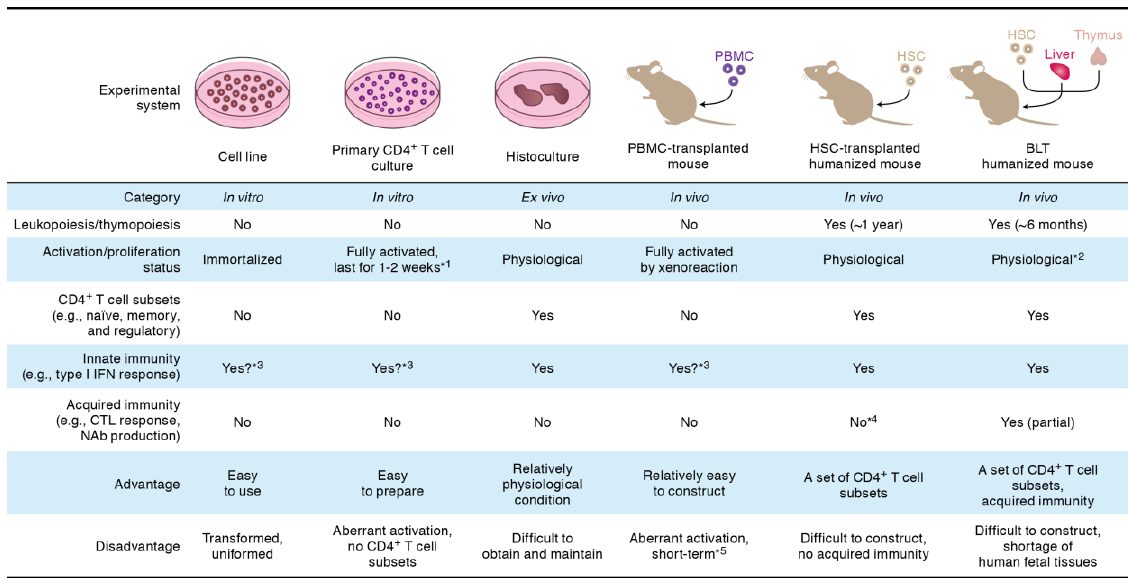
Figure 2. Experimental system for HIV-1 infection. The detailed explanation of each experimental system is described in the text. * 1 , to perform HIV-1 replication assays, primary CD4 + T cells should be artificially activated by mitogens (e.g., phytohemaggluttinin and anti-CD3/CD28 antibodies); * 2 , because human thymocytes are efficiently educated in human thymic transplant ( i.e. , human MHC), the human T cells differentiated in BLT humanized mice may recognize the tissues of recipient mouse as foreign antigen, which can lead to the onset of graft-versus-host reaction; * 3 , these systems are capable of responding type I interferon stimulation, which can lead to the expression of interferon-stimulating genes. However, these systems are incapable of triggering innate immune sensing because of the absence of dendritic cells and macrophages; * 4 , because human thymocytes are educated in the thymus of recipient mouse ( i.e. , murine MHC), the human T cells differentiated in HSC-transplanted humanized mice are unable to efficiently receive the antigen stimulation from human antigen presenting cells; * 5 , the transplanted human PBMCs recognize the tissues of recipient mouse as foreign antigen and cause graft-versus-host reaction, which results in the aberrant xenoactivation. BLT, bone marrow/liver/thymus; CTL, cytotoxic T lymphocyte; HSC, hematopoietic stem cell; IFN, interferon; NAb, neutralizing antibody; PBMC, peripheral blood mononuclear